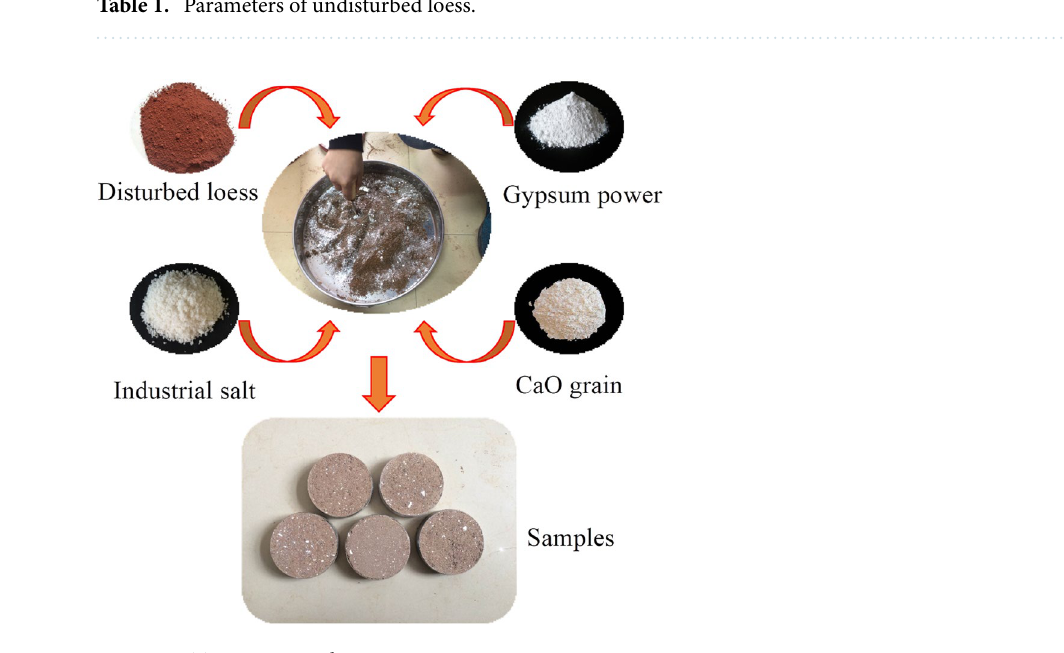
Figure 2. Testing